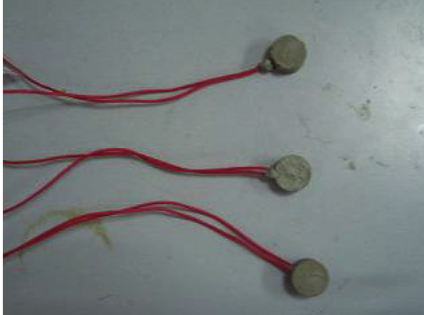
Figure 4: Embedded EMI active